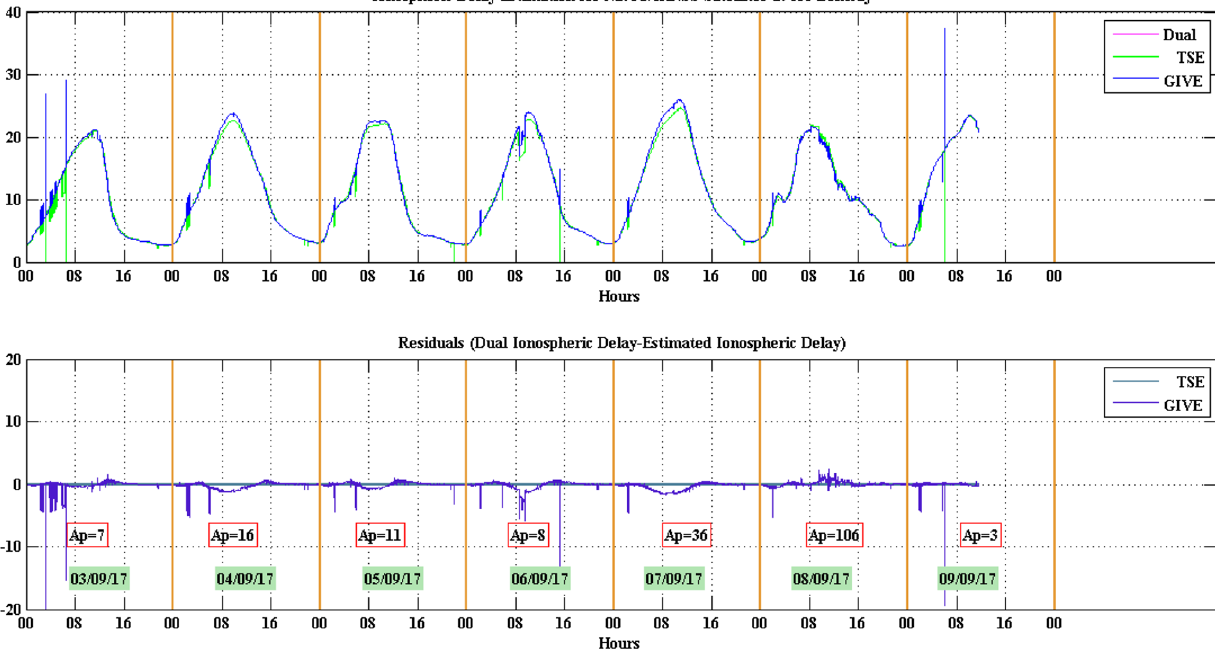
Fig. 9. The average ionodelay performance comparisons of TSE, dual frequency and GIVE model for NavIC/IRNSS satellites at the IIT Bombay on the observation duration (3 – 9 September